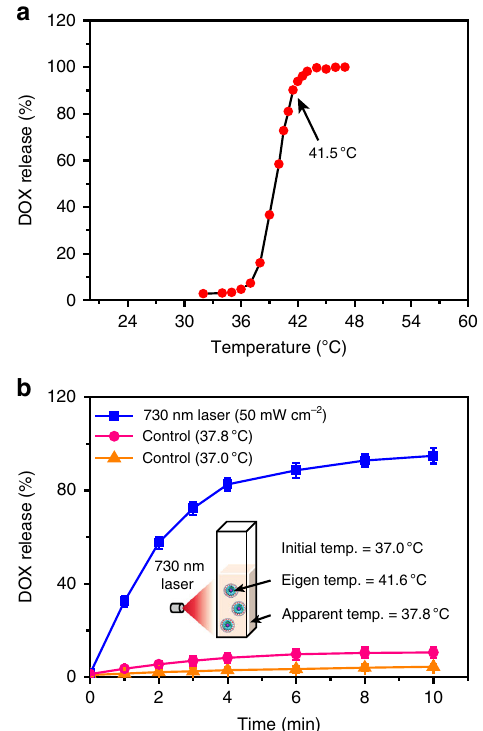
Fig. 4 Drug release behavior of TR-UCNS. a DOX release behavior of TR- UCNS aqueous dispersion (0.5 mg ml − 1 ) under external heating. The temperature varied from 32 to 47 °C. The release rate was normalized to 47 °C. It should be noted that the release rate at 41.5 °C reached to ~90%. b DOX release rate of TR-UCNS aqueous dispersion (0.5 mg ml − 1 )